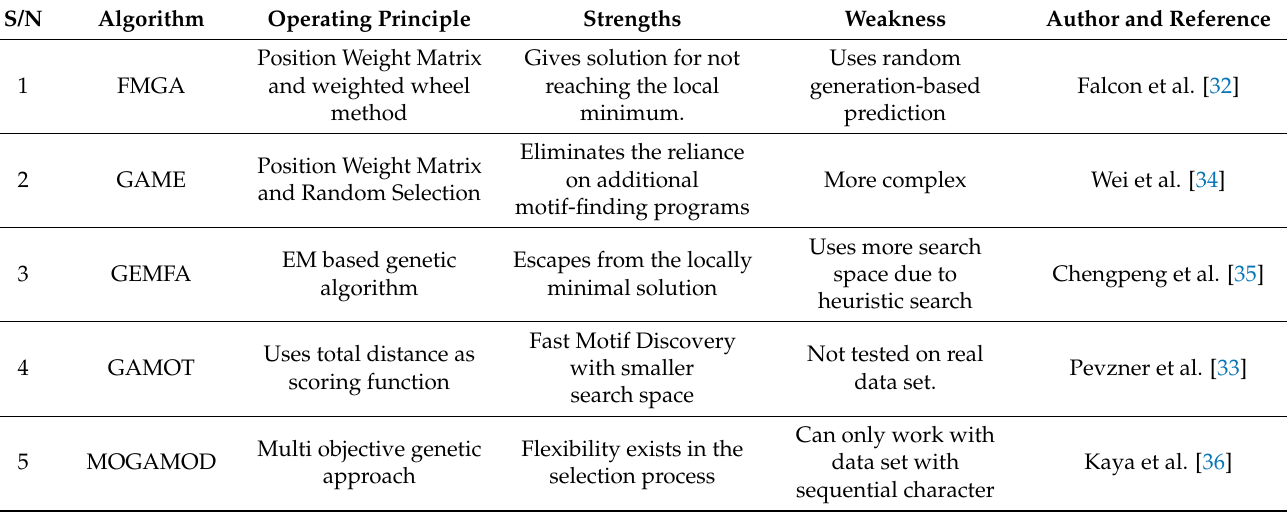
Table A3. List of Motif Discovery Algorithms based on Evolutionary